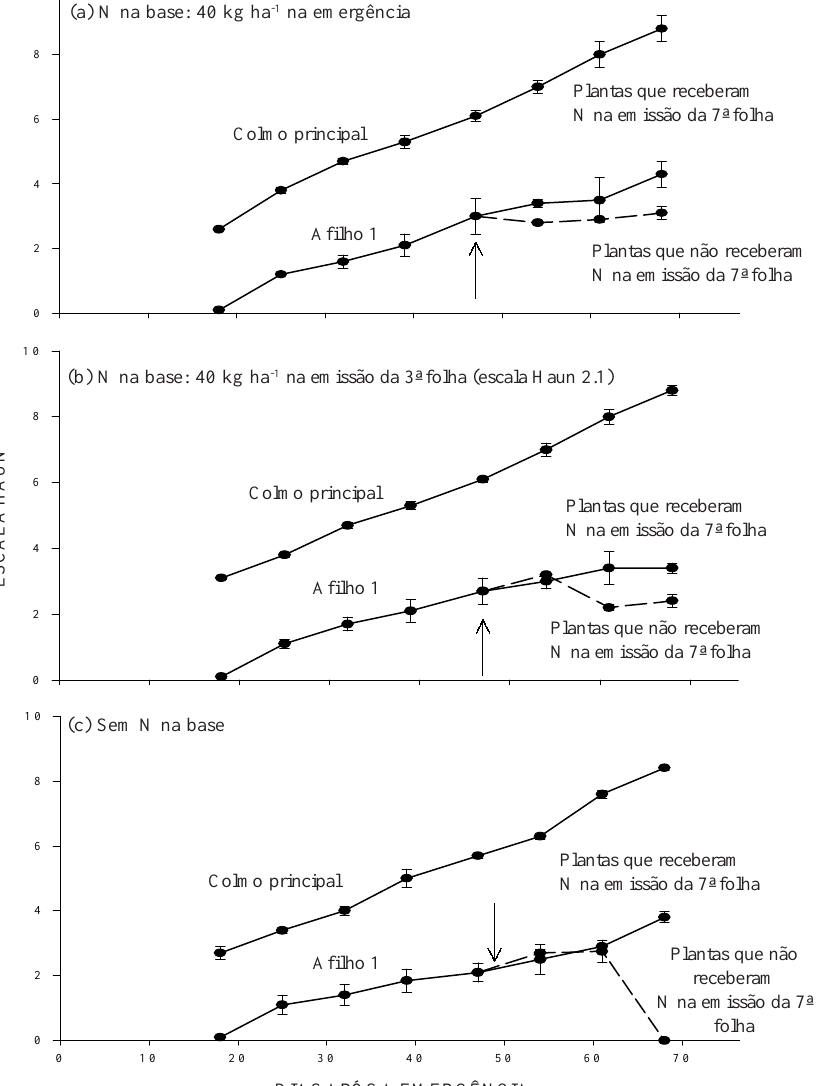
Figura 2. Desenvolvimento foliar (escala Haun) do colmo principal e primeiro afilho, em 1995, em tratamentos com e sem a aplicação de N no momento de emissão da 7ª folha do colmo principal (escala Haun 6.1). Barras verticais representam o desvio-padrão da média. Setas indicam o momento de aplicação de N em cobertura.